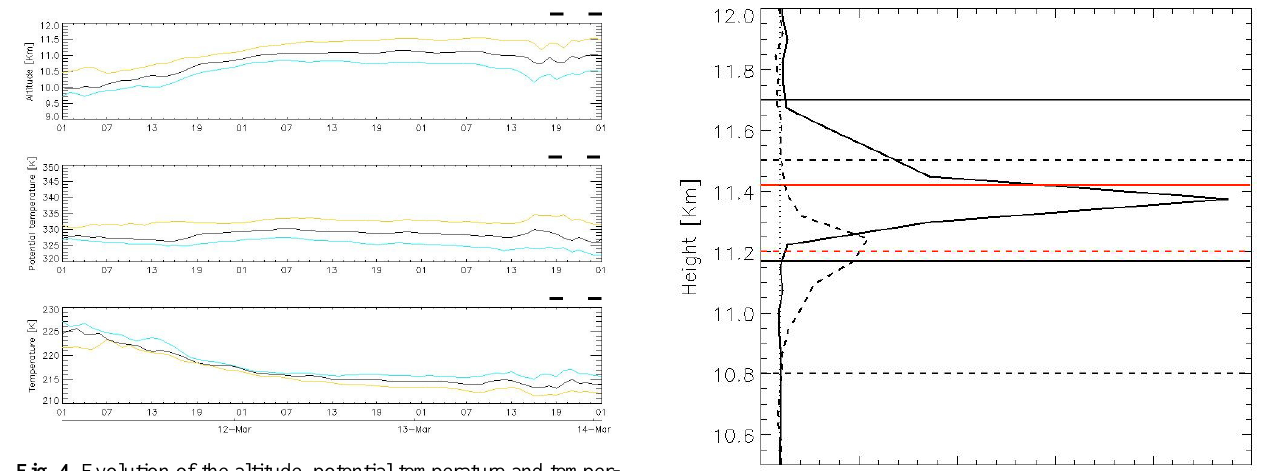
Fig. 4. Evolution of the altitude, potential temperature and temper- ature of the air mass backward trajectories between 11 March 2008 at 01:00UTC and 14 March 2008 at 01:00UTC for three atmo- spheric levels (10.7, 11.2, 11.7km; black, yellow and blue, respec- tively) that include bottom and top heights for the cirrus observed by OHP and RTV lidars. Horizontal delimited black bars indicate air mass passage above OHP and RTV sites (13 March 2008 at around 19:00UTC and 14 March 2008 at 01:00UTC, respectively).